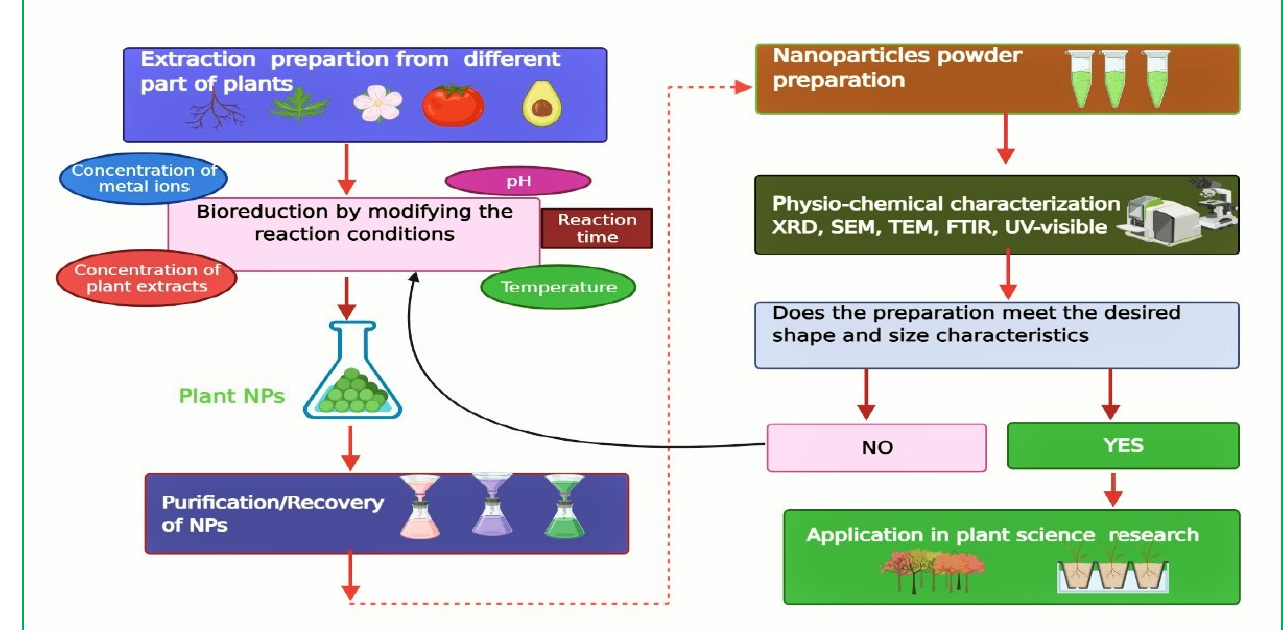
Figure 2. Schematic diagram showing the preparation of green synthesized nanoparticles from different parts of the plant. Plant extract preparation from different plant parts such as roots, leaves, flower, fruits and seeds are used in the synthesis of nanoparticles (NPs). The bio-reduction mediated synthesis of NPs is controlled by several factors including concentration of plant extracts and metal ions, pH of the solution, reaction time, and temperature at which reaction is carried out. Purifications and characterization of NPs play a determinant role in the synthesis of desired NPs, which could be beneficial in plant science and research-oriented disciplines. The reaction should be restarted from the bio-reduction process if the synthesized NPs do not meet the desired morphological characteristics. Black, red and dotted arrows show the steps involved in NPs synthesis.